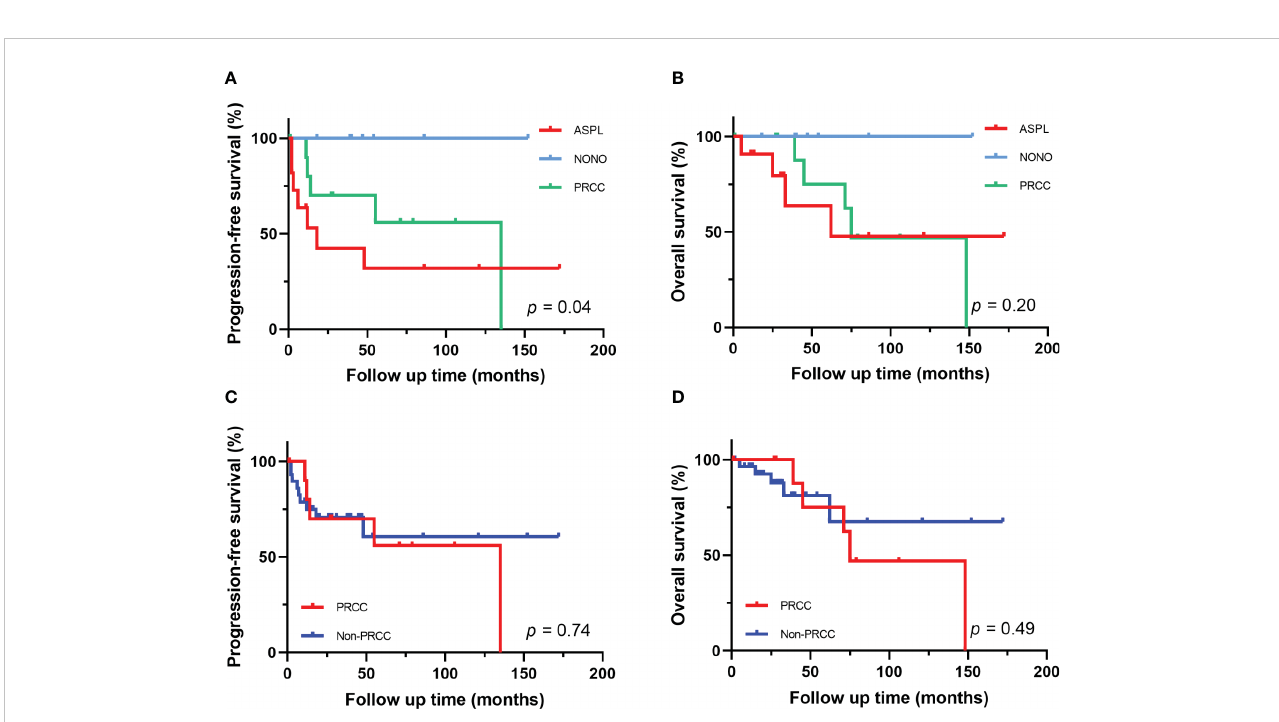
FIGURE 5 Survival analysis of different fusion partners. (A, B) PFS and OS for patients with different fusion subtypes. (C, D) PFS and OS for patients with PRCC-TFE3 fusion and non-PRCC